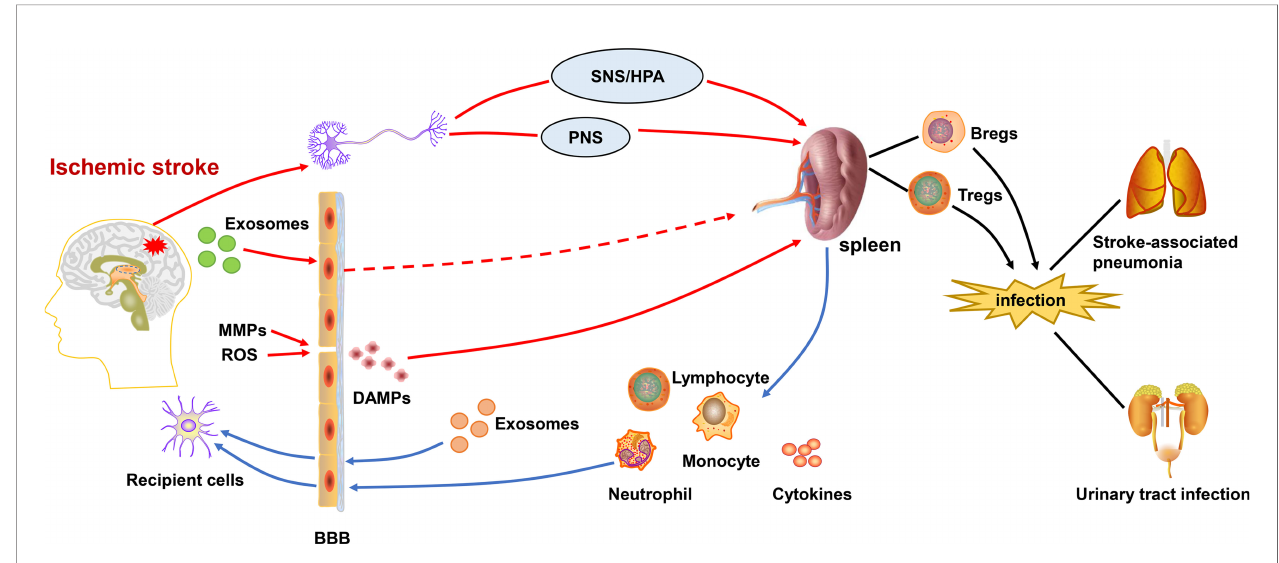
FIGURE 1 | Central-peripheral/brain-spleen communication after ischemic stroke. After the onset of ischemicstroke, ROS and activated MMPs exacerbate the destruction of the BBB. DAMPs are released into the periphery, activatingtheimmune system.In fl ammatory signalsfrom brain are transmitted to the spleen viaSNS/HPA andPNS. Exosomes also play a rolein linking central-peripheral immunity. The spleen isableto mobilize themigration of immune cells and therelease ofcytokines, which affects the neuroin fl ammation in ischemicstroke. Correspondingly, the splenic response also leads to peripheral immunosuppression,which increases the riskofstroke-associated pneumonia andurinarytract infections. BBB, blood-brain barrier; DAMPs, damage-associatedmolecular patterns; SNS/HPA, sympatheticnervous system/hypothalamus- pituitary-adrenaline axis; PNS, parasympathetic nervous system;MMPs, matrix metalloproteinases; ROS, reactive oxygen